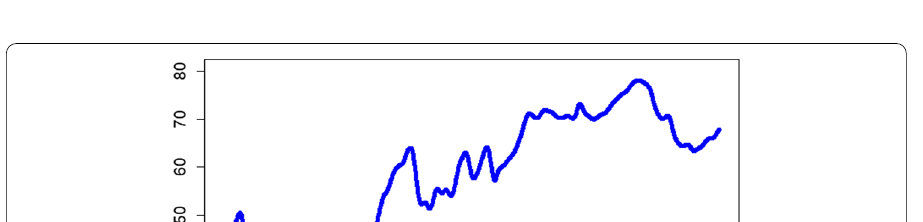
Fig. 4 Frequency domain spillover using BK